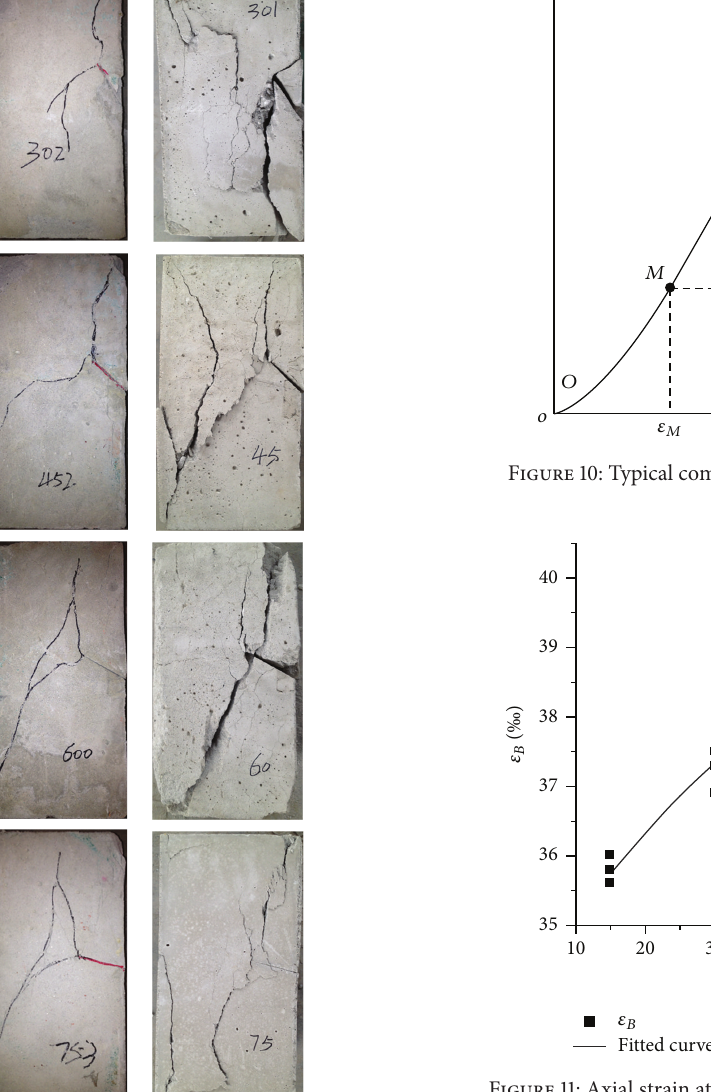
Figure 11: Axial strain at residual strength level versus crack orien-